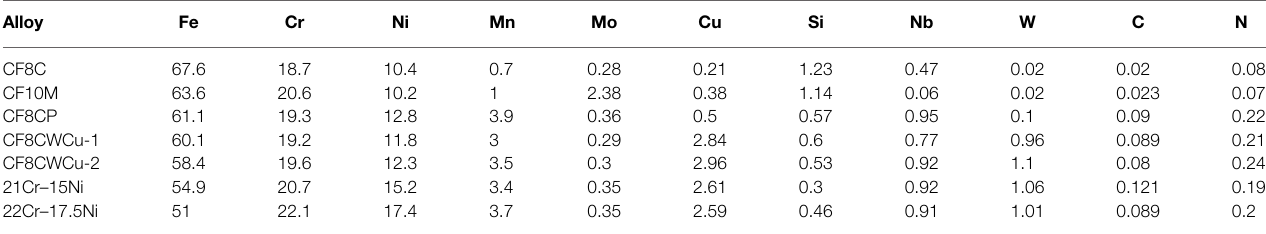
TABLE 1 | Composition of the cast alloys measured by inductively coupled plasma (ICP), combustion, and inert gas fusion (IGF) analyses . Alloy Fe Cr Ni Mn Mo